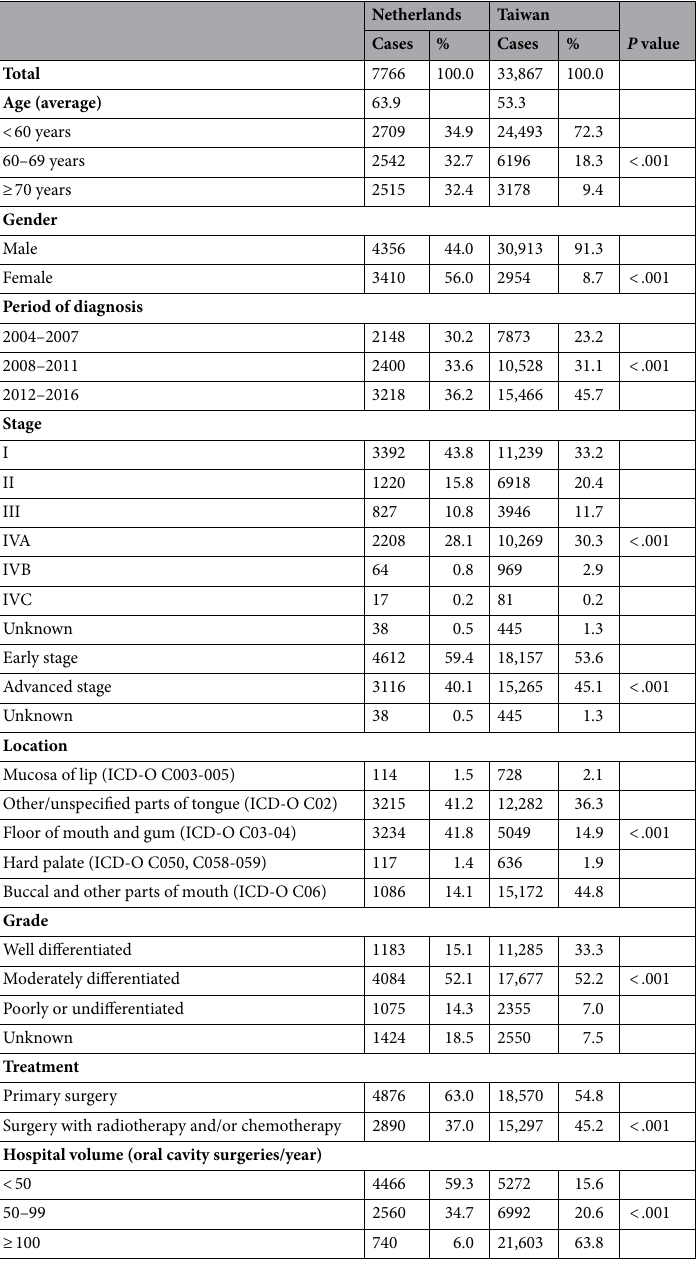
Table 1. Patients